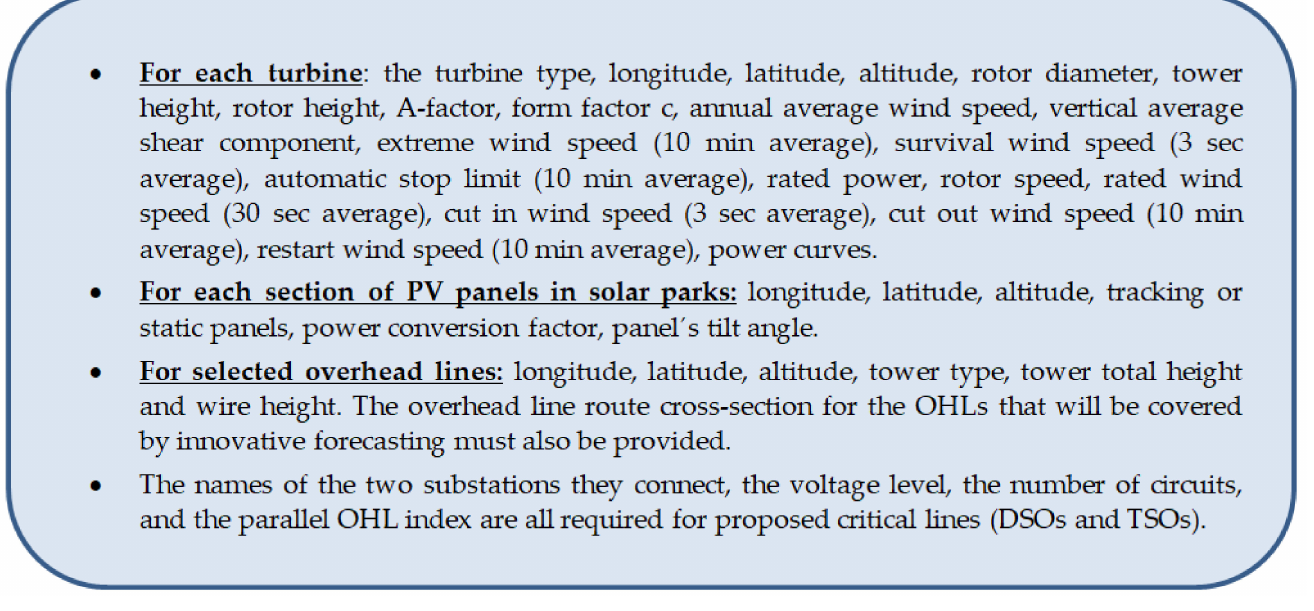
Figure 7. Technical data for PV parks and wind